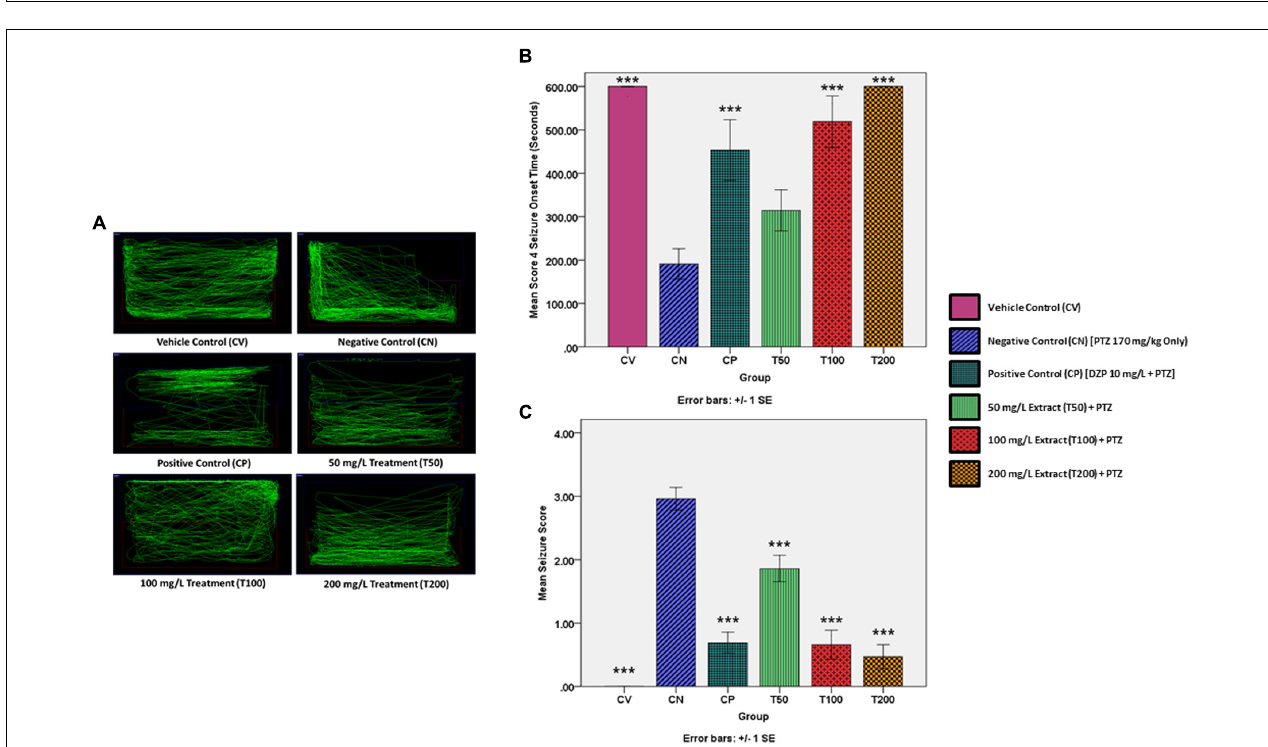
FIGURE 2 | PTZ-induced behavior and locomotion for each experimental group. (A) Representative zebrafish locomotion pattern for the vehicle, negative and positive control groups, as well as the extract treated groups. (B) Represents the score 4 seizure onset time (seconds) for the vehicle and positive controls as well as the extract treated groups, as compared to the negative control (CN, 170 mg/kg PTZ Only) (C) Represents the mean seizure score for the vehicle and positive controls as well as the extract treated groups, as compared to the negative control (CN, 170 mg/kg PTZ Only). The data is expressed as Mean ± SEM, n = 10